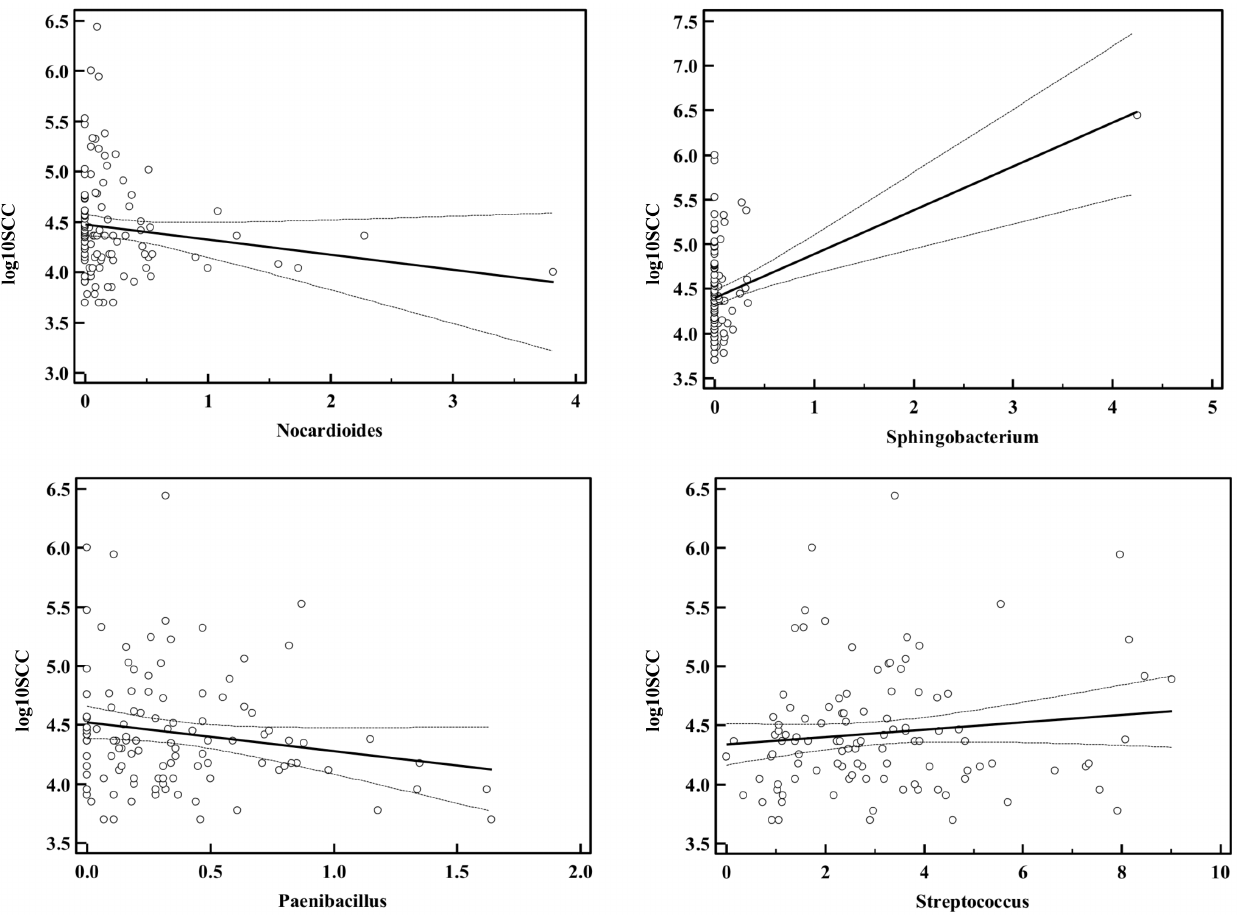
Figure 5. Genera prevalence by log10 somatic cell counts (log10SCC) for genera that are associated with an increased or decreased immune response as measured by SCC in healthy quarters; a generalized linear model was used to predict the 10 Log of quarter SCC. Percent of the sequences for each of the predominant genera were used as predictor variables while at the same time correcting for herd effects.